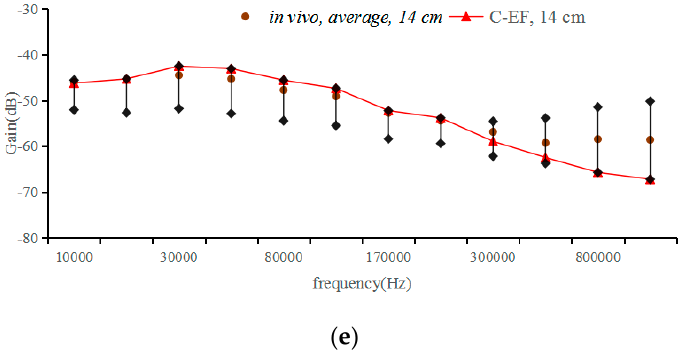
Figure 10. Comparison between in vivo measurements and C-EF channel estimation results, measured on 10 test subjects at different distances, ( a ) error of the experiment and simulation results, ( b ) the results of experiment and simulation; ( c ) results under 6 cm; ( d ) results under 10 cm; ( e ) results under 14 cm.